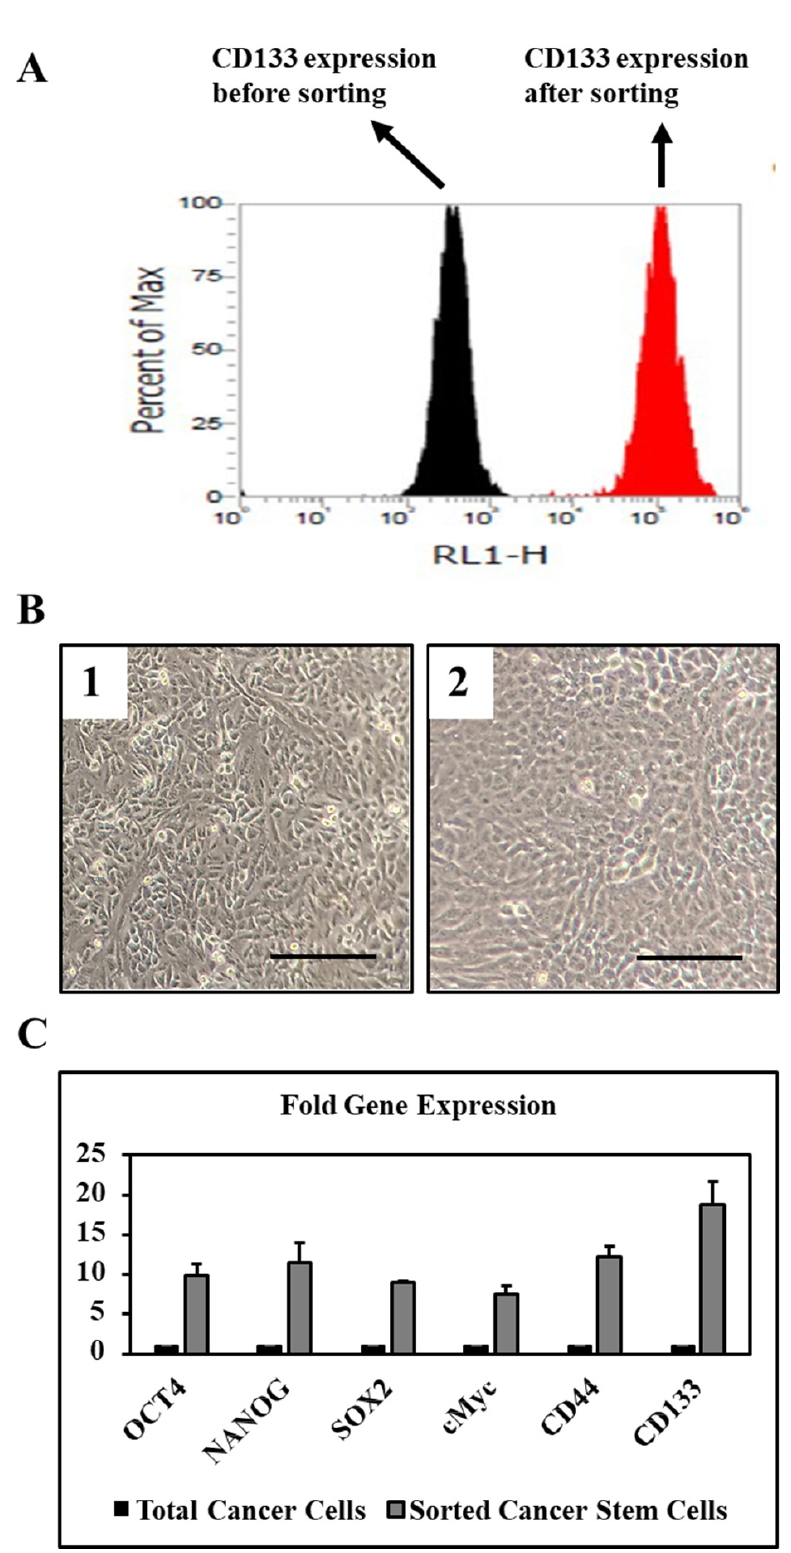
Figure 1. OSCC tissues were digested enzymatically to prepare single cell suspensions and further used for experiments and culture. ( A ) CD133 expression in magnetically sorted oral cancer stem cells. ( B ) Morphology of total cancer cell population B1 and CD133+ sorted cancer stem cells B2. Scale bar = 100 µ m. ( C ) Fold gene expression of stemness and pluripotency related genes in CD133+ sorted cancer stem cells.